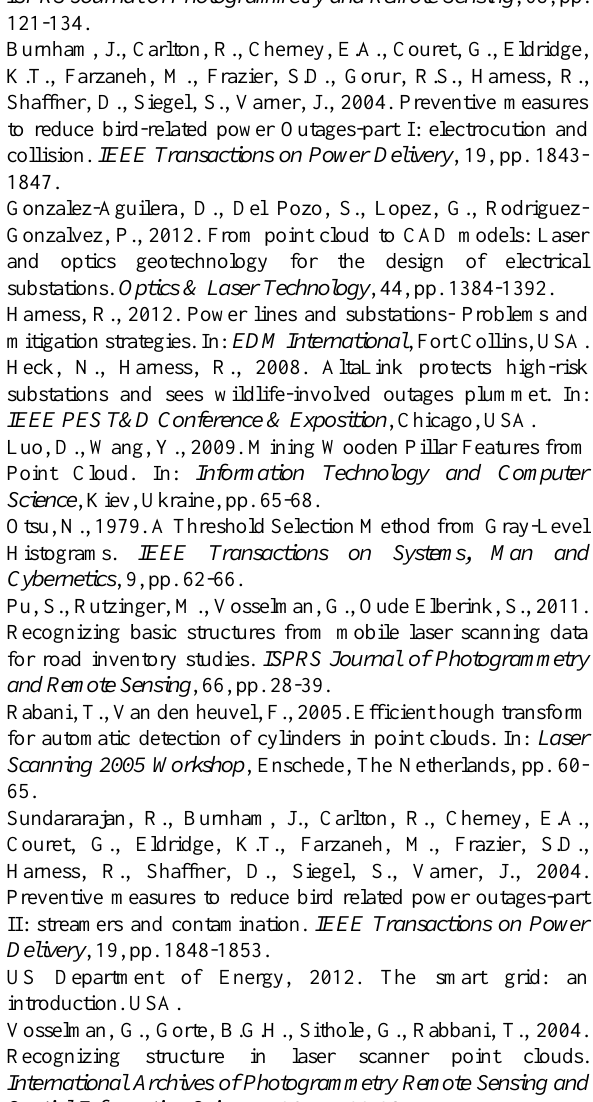
Figure 13. Detected insulators shown by blue colour